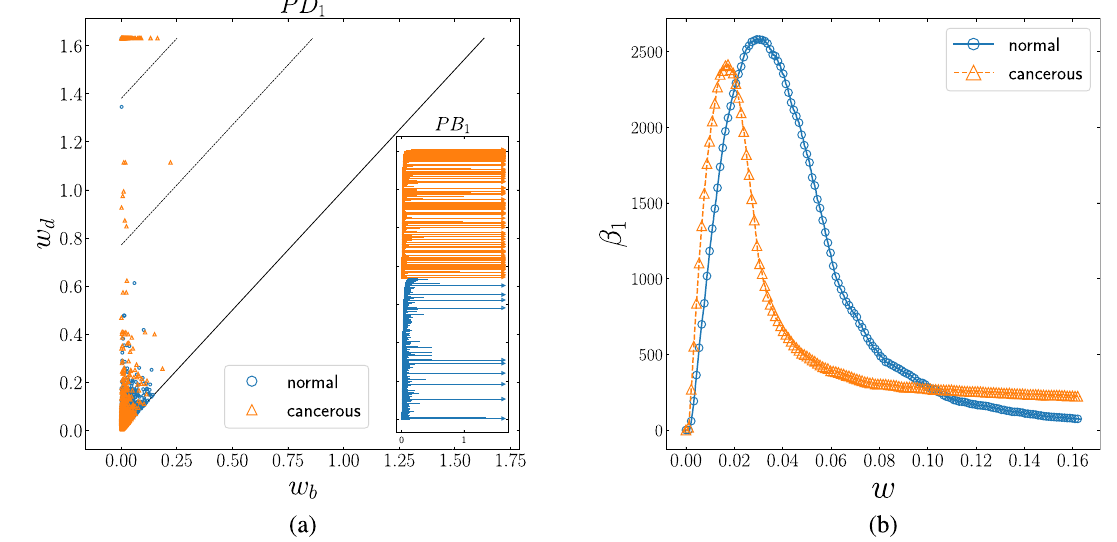
Figure 5. (a) Persistence diagram of 1-homology group ( PD 1 ) for normal (blue circles) and cancerous (orange triangles) interaction network. There are many persistent loops (persistence pairs between dashed-lines) in cancerous network rather than normal network. Inset: Corresponding persistence barcode ( PB 1 ) for normal (blue bars) and cancerous (orange bars) network. The long bars correspond to the persistent loops in normal and cancerous networks, and the number of survived loops (arrows) in the cancerous network is more than the normal network. (b) The number of topological loops as function of threshold ( β 1 -curve) for normal (blue circle) and cancerous (orange triangle) network. The networks become loop-full at different thresholds (0.02 and 0.03 respectively), whereas they include the same number of loops almost at 0.02 and 0.10. More importantly, the tail of curves show that the cancerous network is loopful, but the normal network is almost loopless.